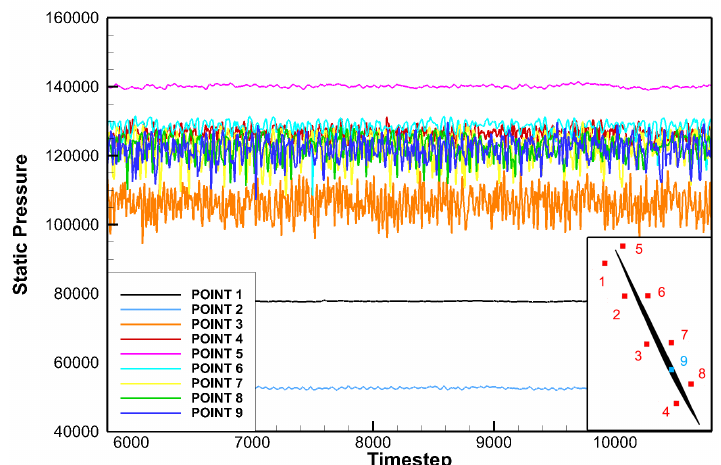
Figure 10. Static pressure history at NS in DES calculation.